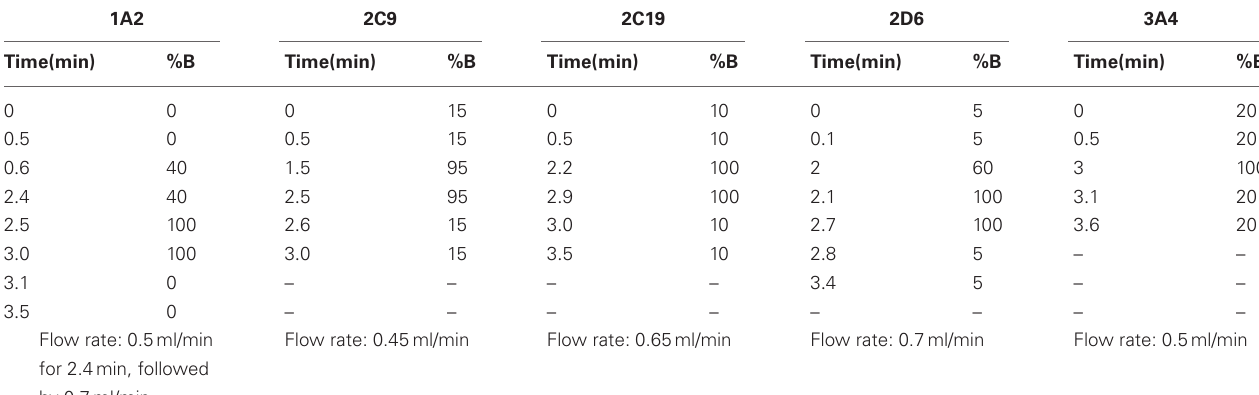
Table A4 | Elution conditions used for each specific to each